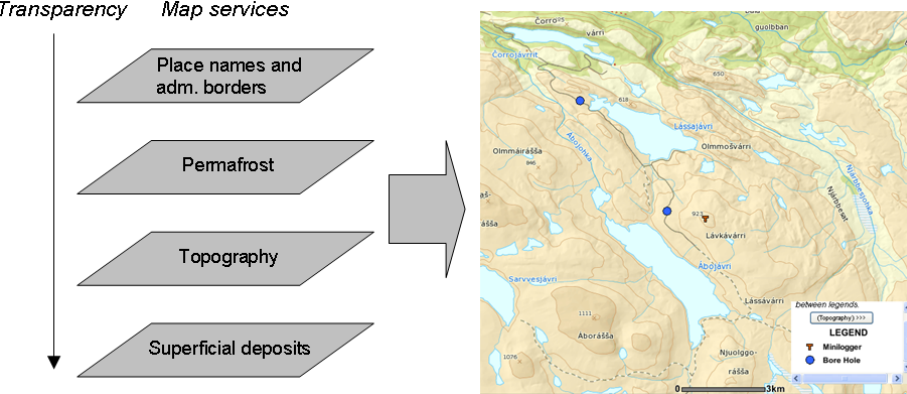
Figure 6. Compilation of di ff erent map layers from di ff erent vendors into a composite map. Transparency can be set by the user for the individual map services. The permafrost Map service is the georeferenced data from the Oracle module. The map shows the Abojavri study area with topography and place